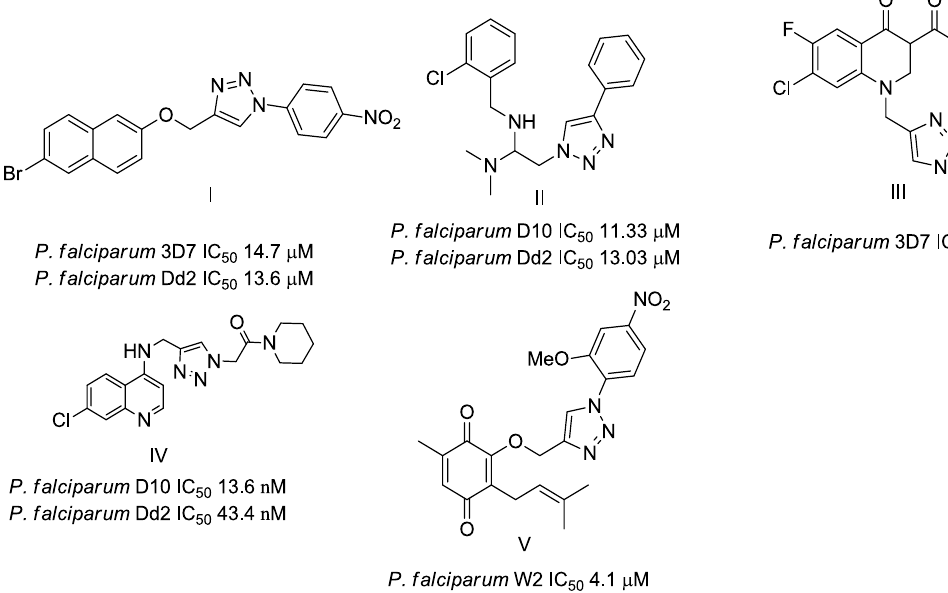
Figure 1. Triazole compounds with a promising antimalarial activity.